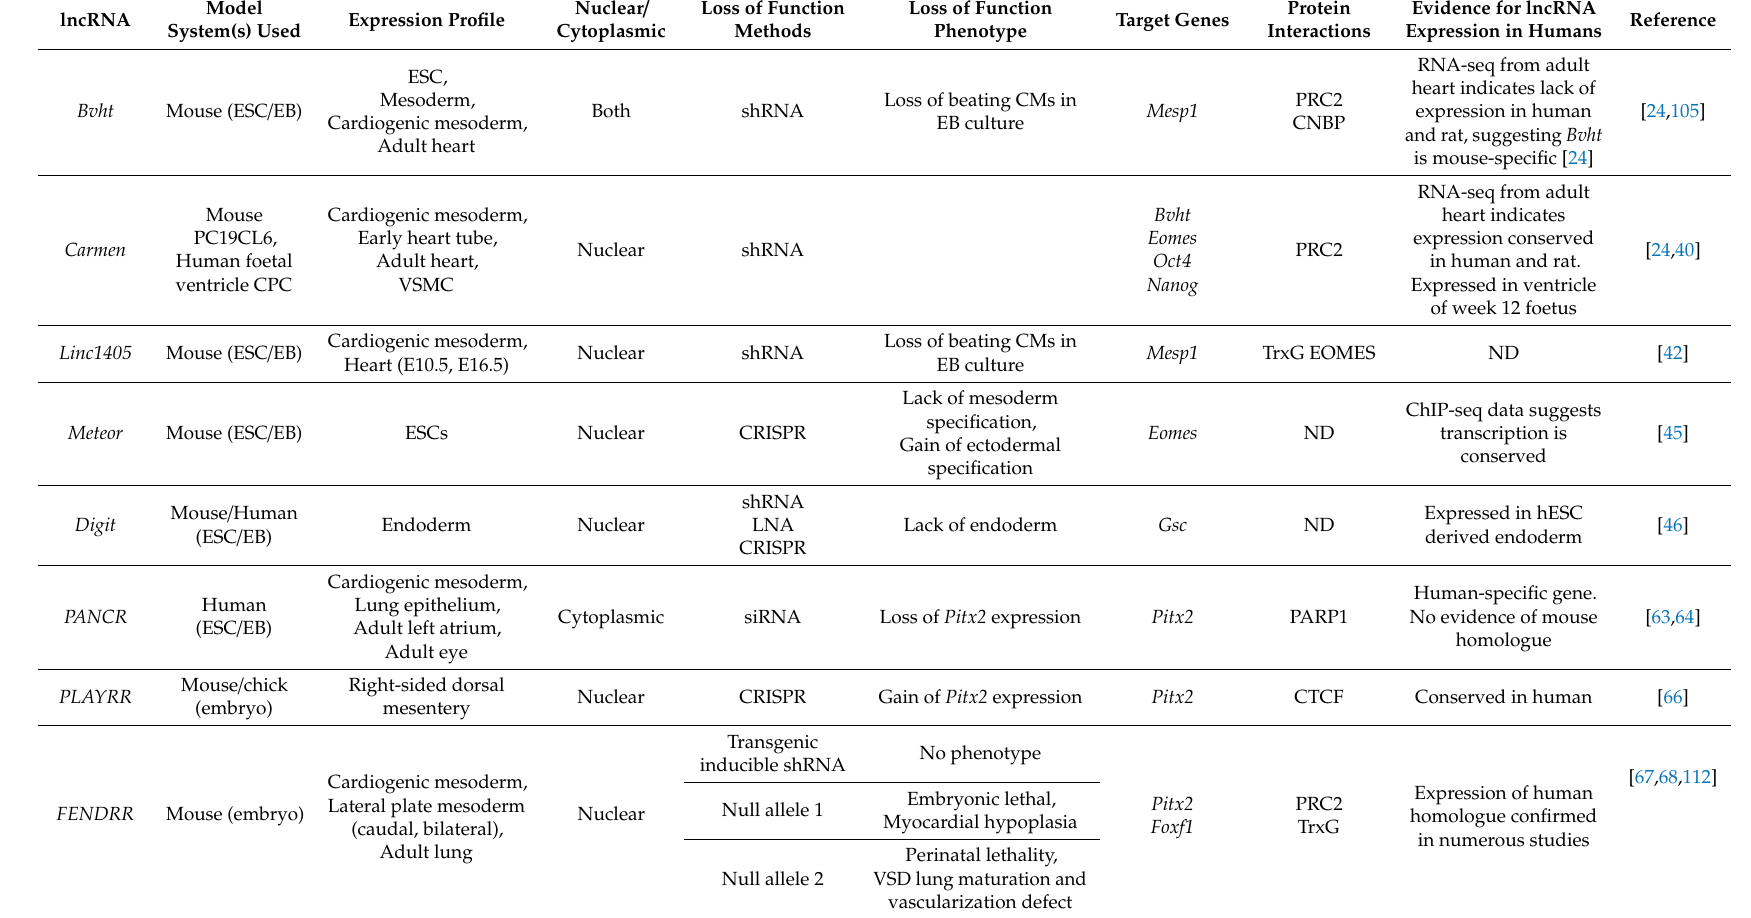
Table 1. Summary of lncRNA discussed in the